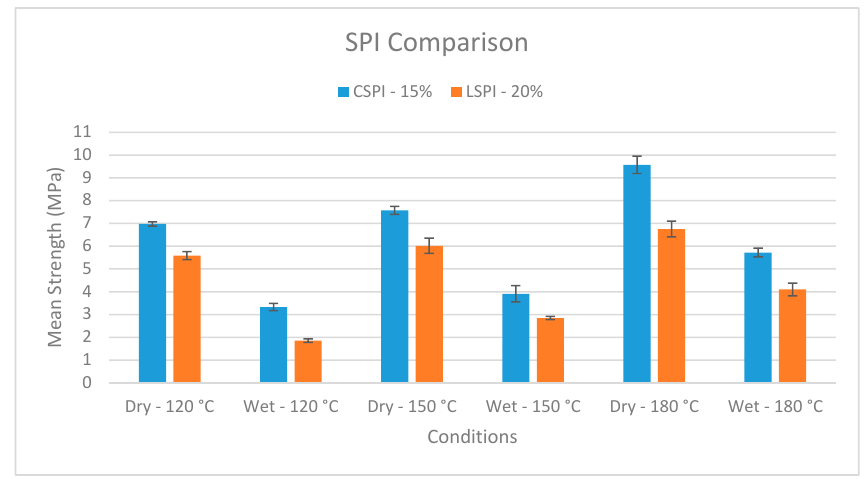
Figure 3. Wet shear strengths of soy protein isolate adhesive with maple veneer bonded at different temperatures. CSPI: commercially available soy protein isolate; LSPI: lab soy protein isolate.